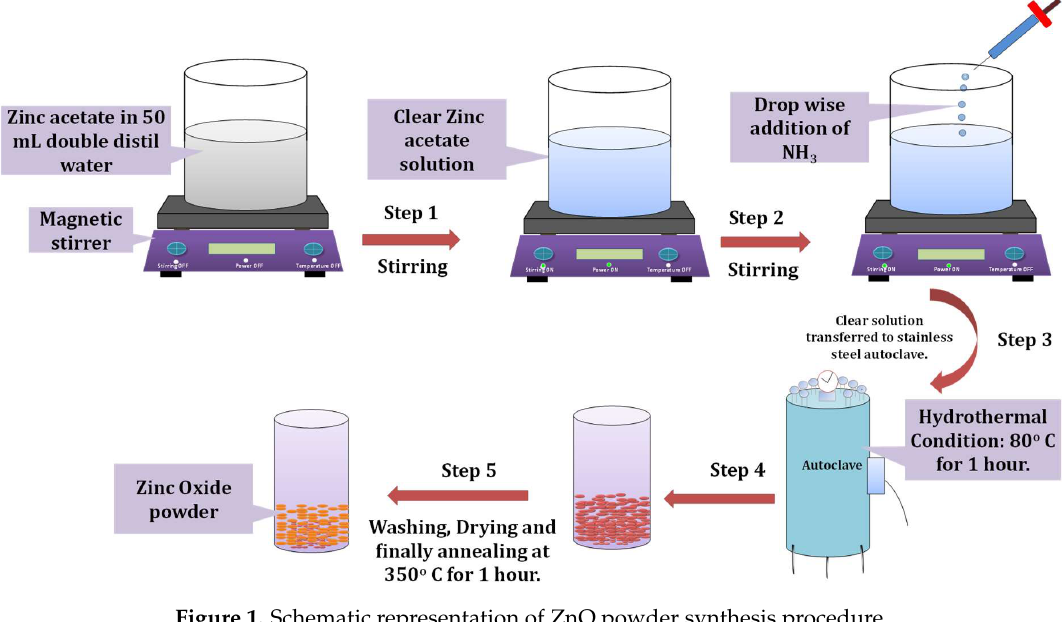
Figure 1. Schematic representation of ZnO powder synthesis procedure.